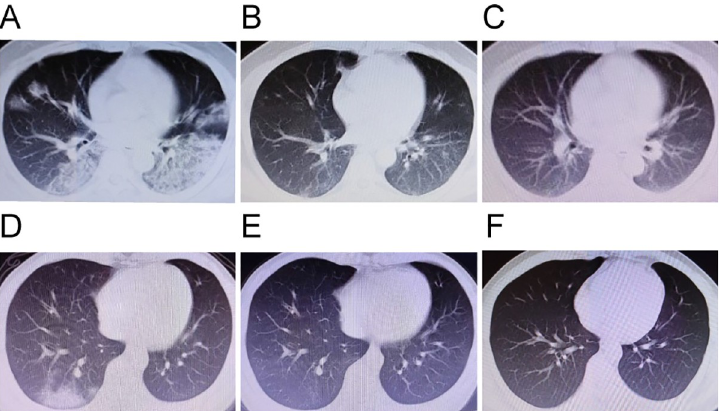
Fig 3. Chest CT images. The representative chest CT images of the moderate survivors. (A-C) A 38-year-old man showed bilateral ground-glass opacity co-existed with subsegmental areas of consolidation on admission (A), the above lesion improved significantly at discharge (B), and the above lesion improved further 4 weeks after discharge (C). (D-F) A 26-year-old man showed bilateral ground-glass opacity on admission (D), the above lesion improved significantly at discharge (E), and the above lesion absorbed completely 4 weeks after discharge